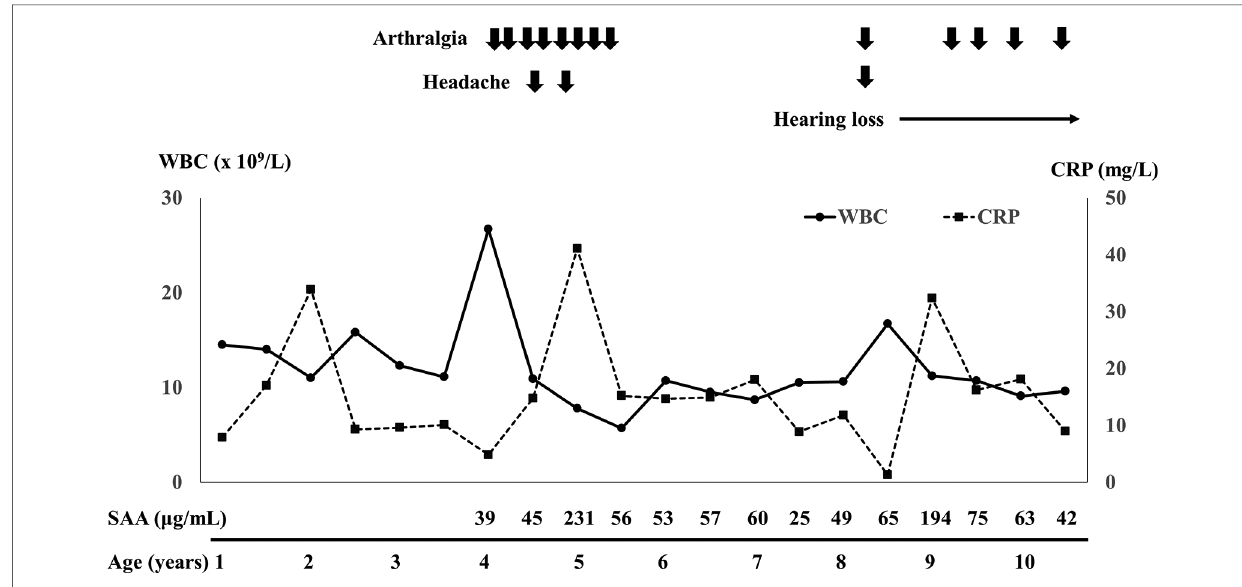
FIGURE 1 Clinical course and serial changes of laboratory data after 1 year of age. WBC, white blood cell; CRP, C-reactive protein; SAA, serum amyloid